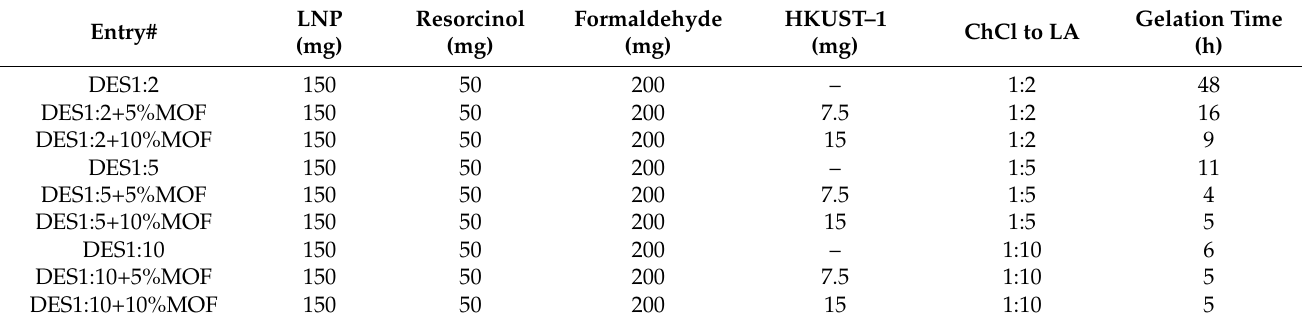
Table 1. Gelation time of the LRF gels under different